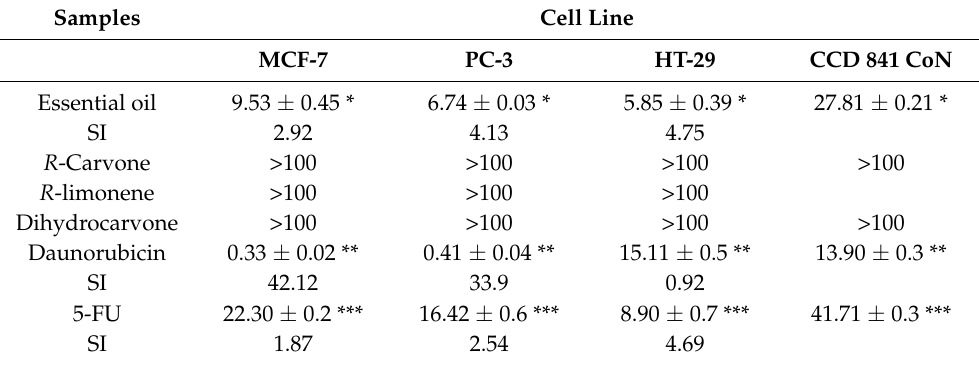
Table 3. IC 50 a ( µ g/mL) and selectivity index (SI) of A. polystachya essential oil and main components tested on MCF-7, PC-3, and HT-29 cancer cell lines, and on CCD 841 CoN normal cell line.